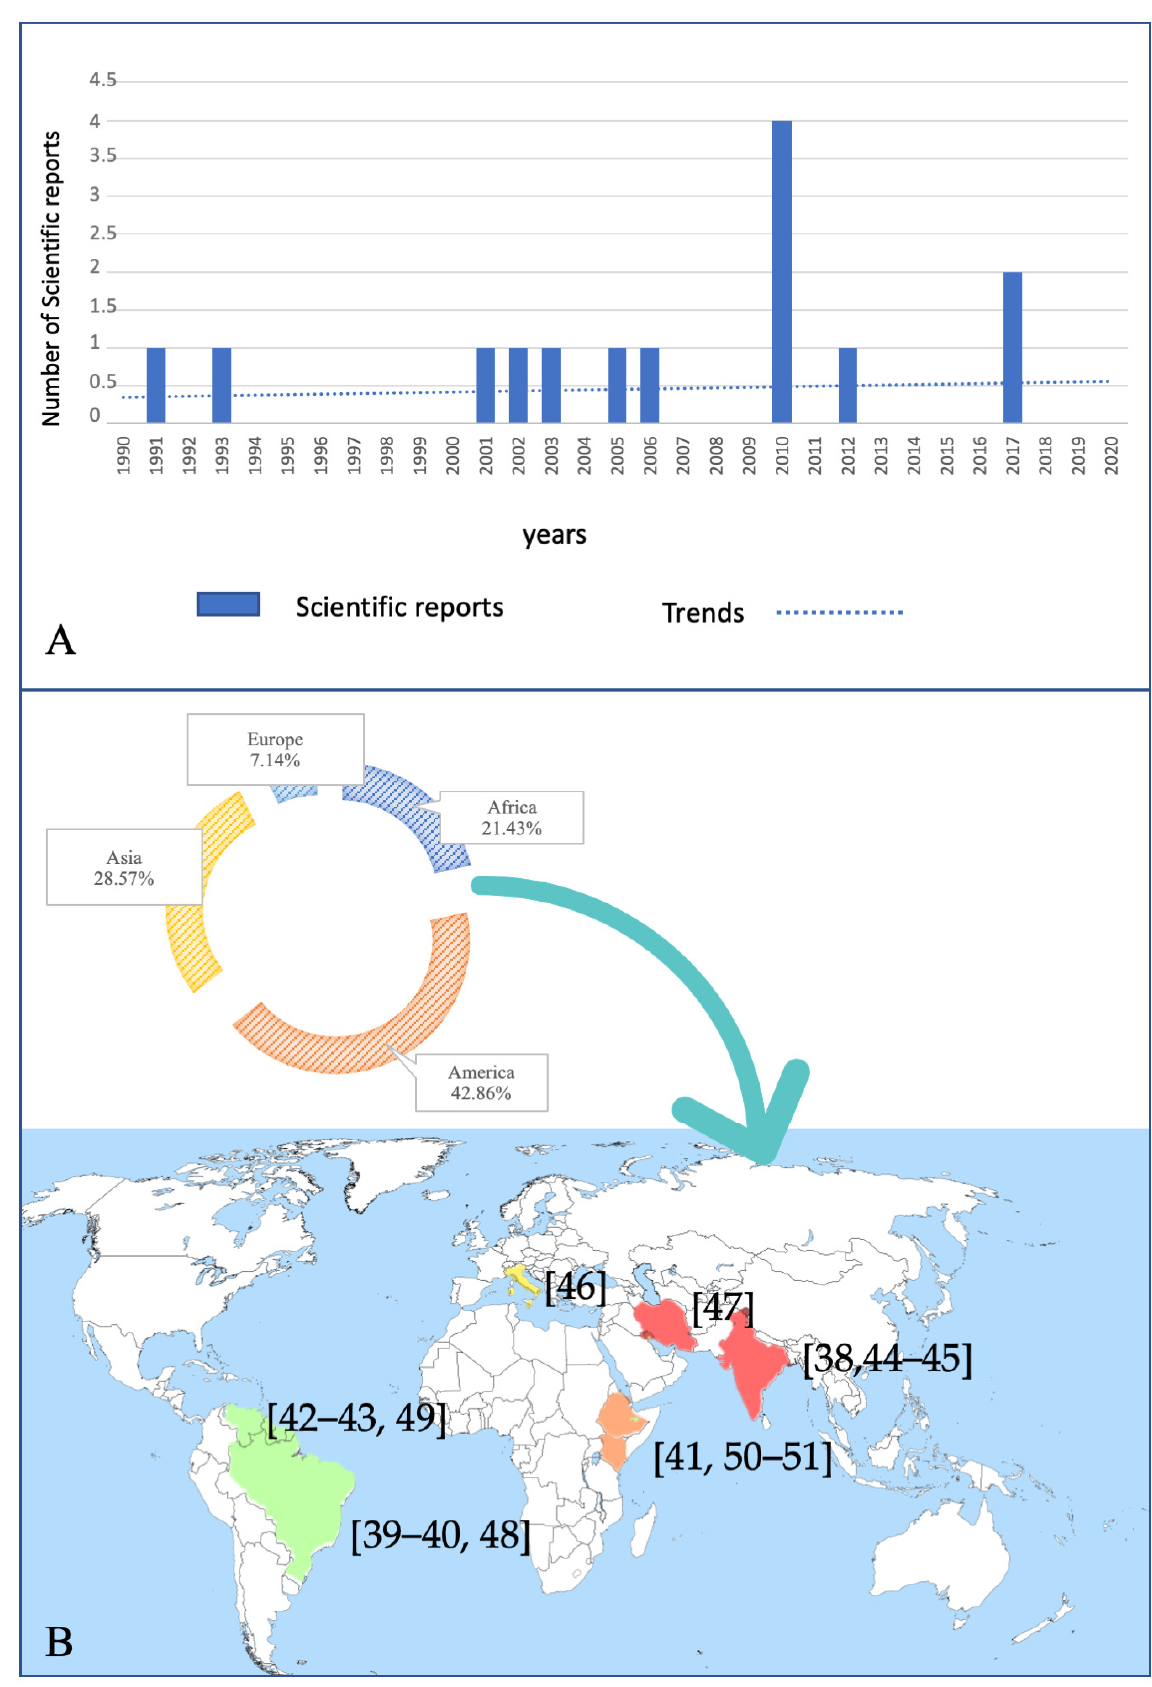
Figure 2. Number of scientific reports in the study period ( A ) and their geographical origin ( B ).